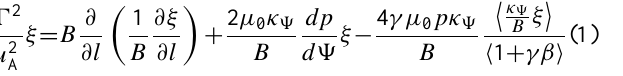
process after the formation of a neutral line. As shown in Fig. 2 and Fig. 5 in next section, a narrow band of closed field lines in the Earthward outflow region near the reconnection site (Earthward of the plasmoid) become highly